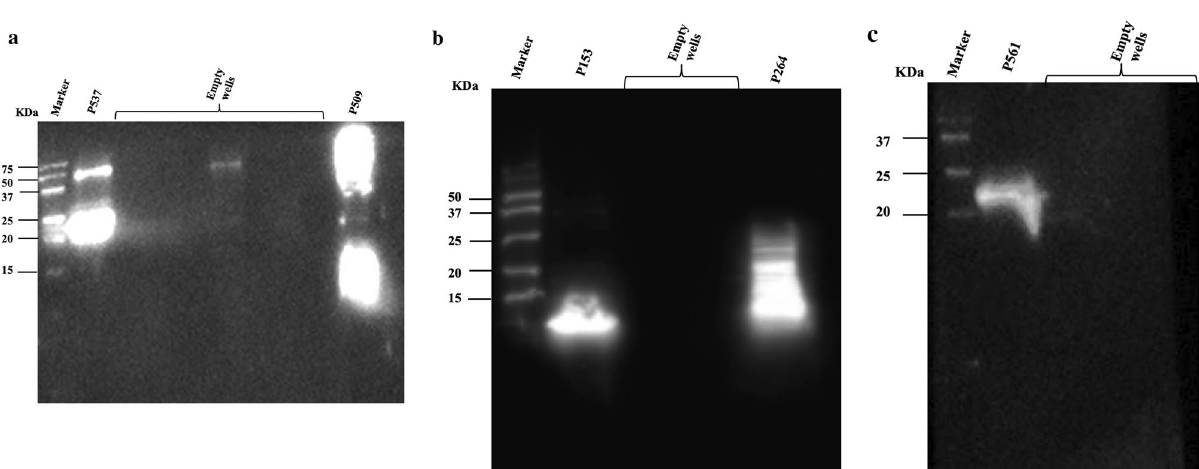
Figure 3. Western blot analysis of chicken antibodies raised against recombinant forms of ( a ) P537 and P509, ( b ) P153 and P264, and ( c )